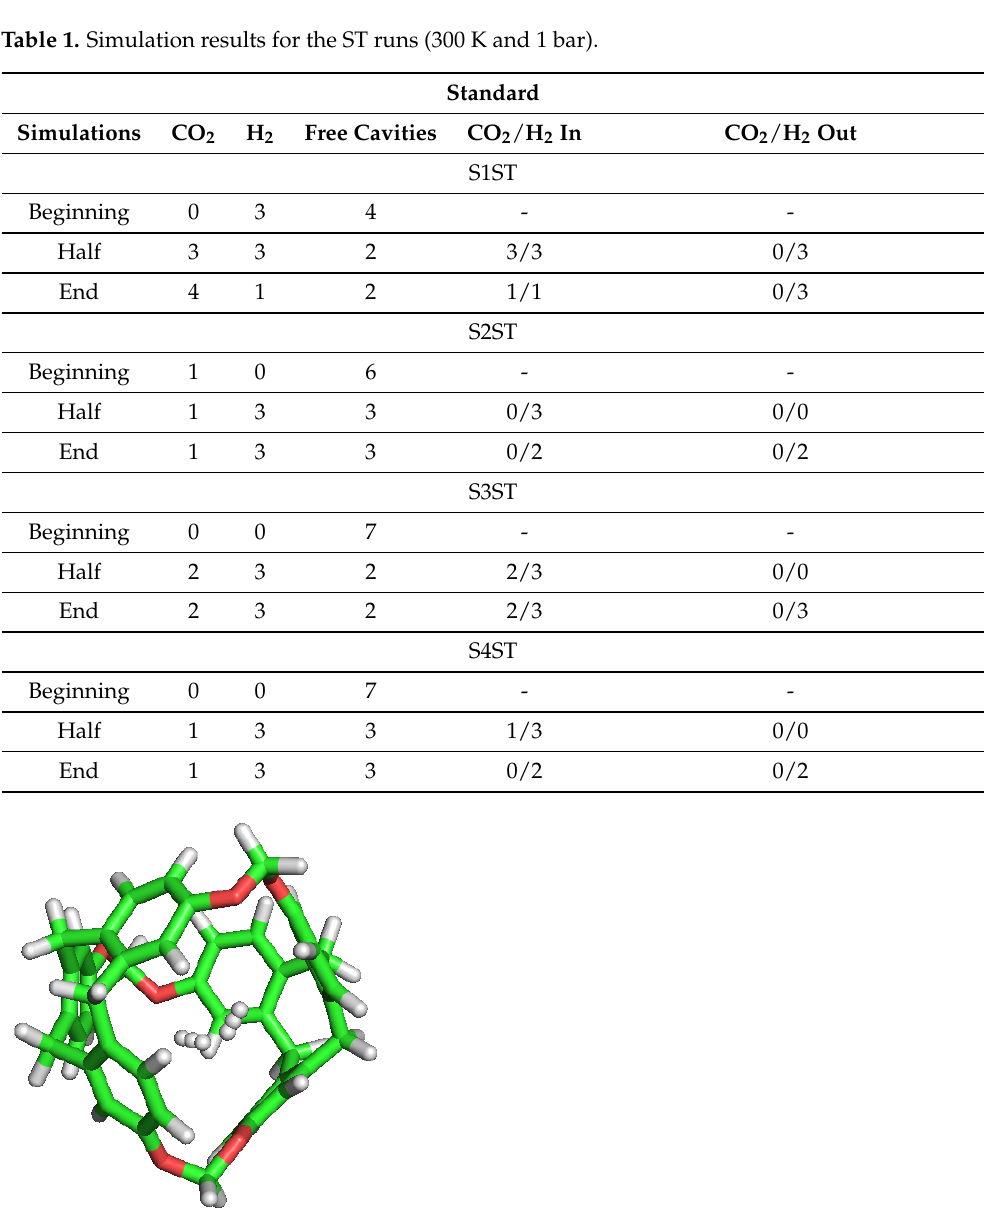
Figure 4. Double occupation of the same cavity by two different H 2